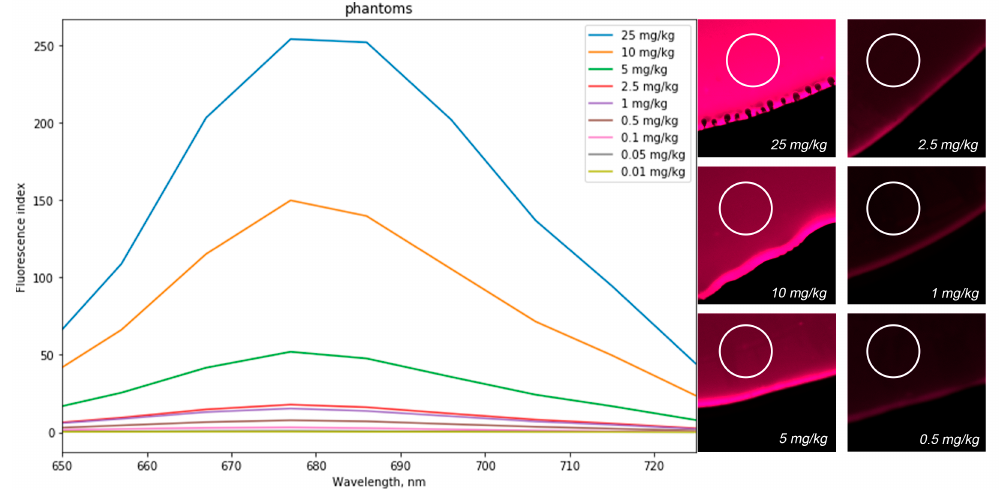
Figure 6. Fluorescence spectra of MB phantoms and images of phantom drops obtained by using laser scanning confocal